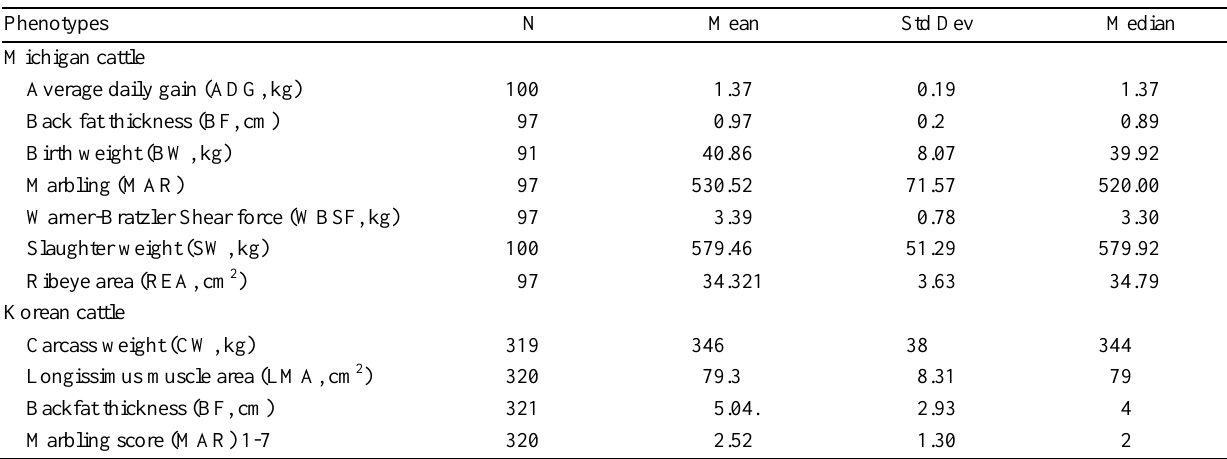
Table 1. Means and standard deviations for growth, carcass and beef quality traits measured on MCA/MSU and Korean